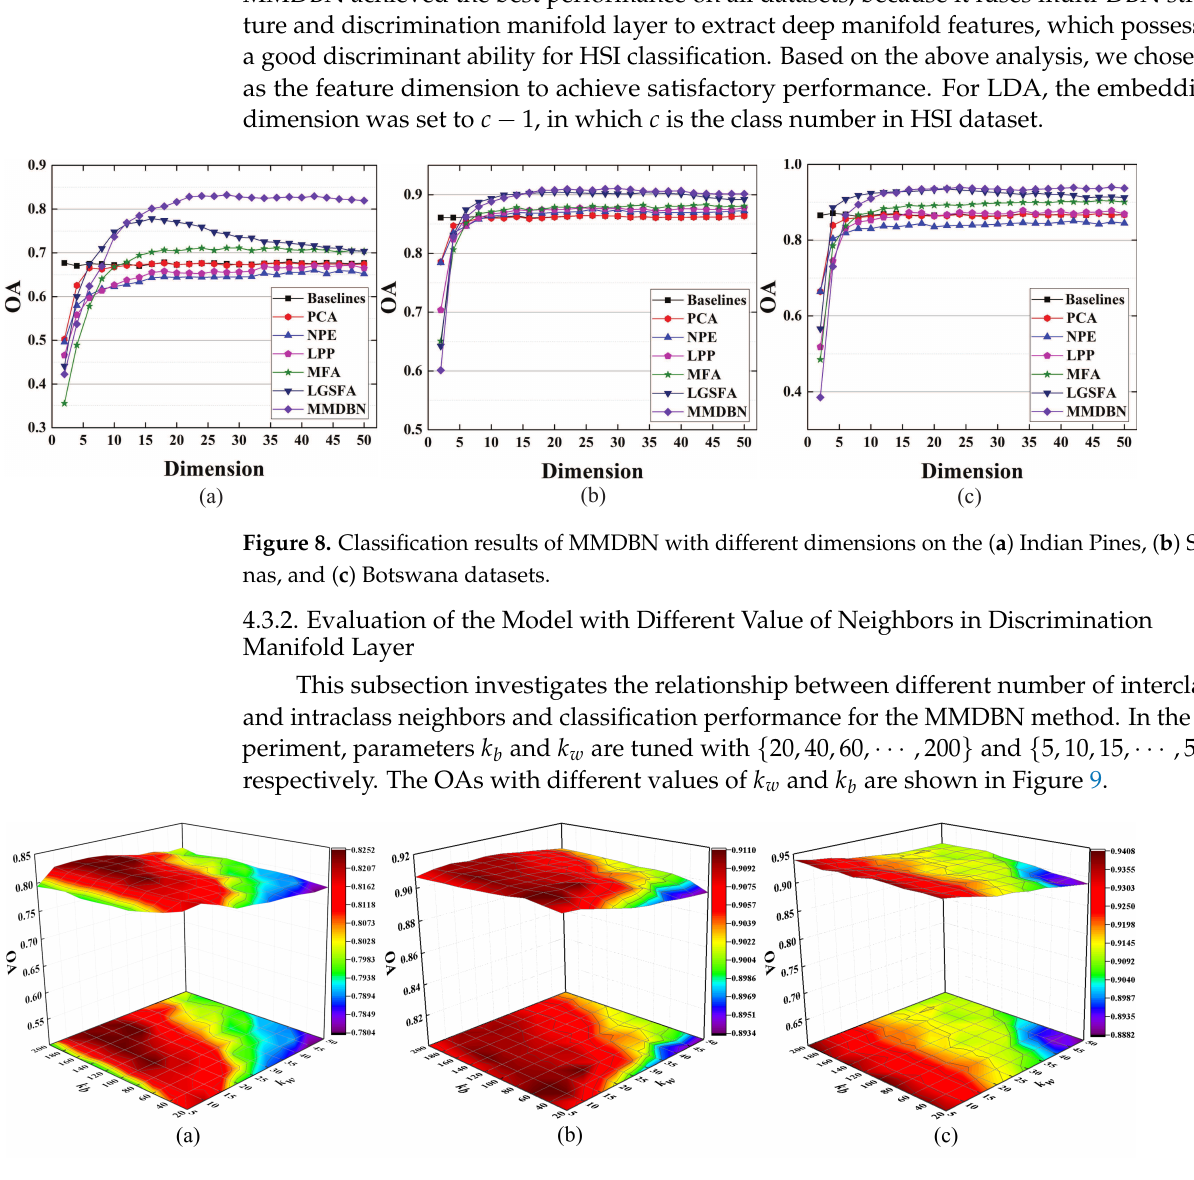
Figure 9. Classification results of MMDBN with different values of k w and k b on ( a ) Indian Pines, ( b ) Salinas, and ( c ) Botswana